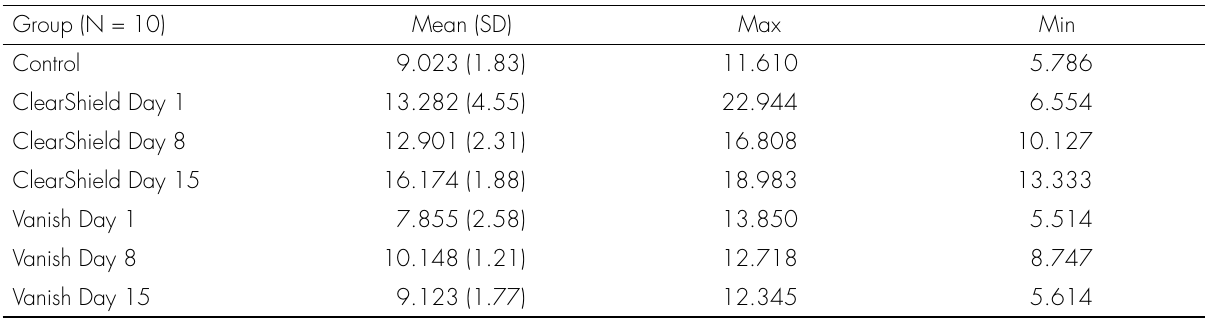
Table IV. Means (standard deviations), minimum and maximum shear bond strength values (MPa) without possible